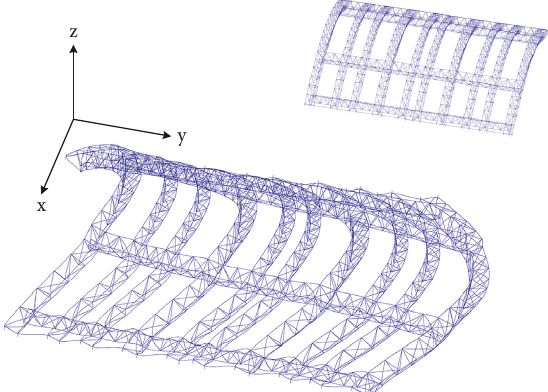
Figure 13: The 1st mode shape